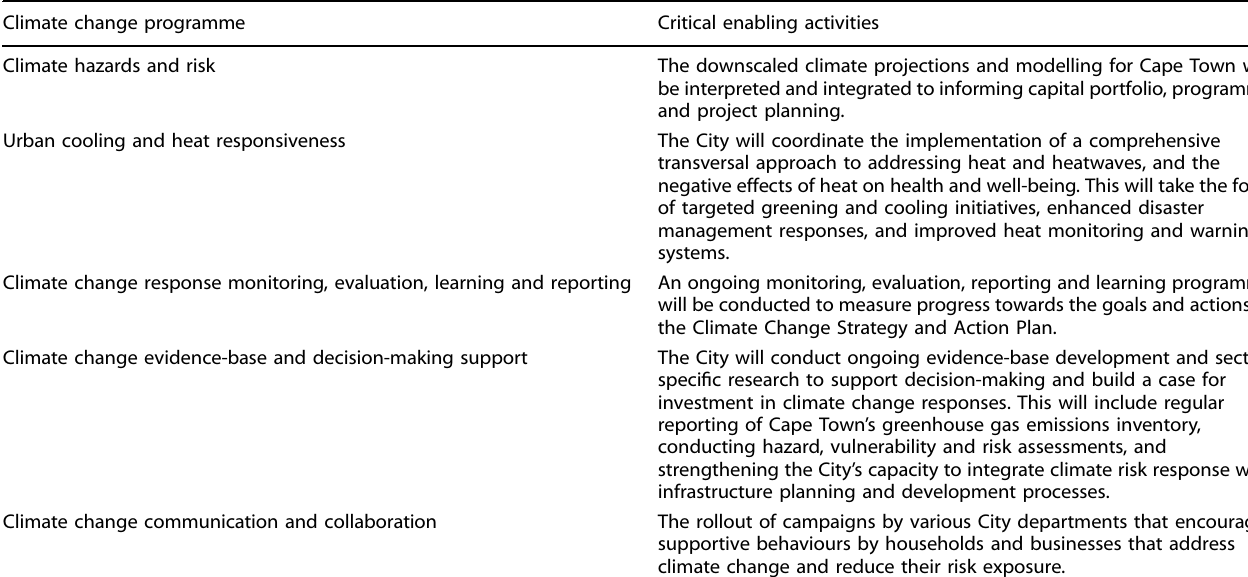
Fig. 1 The strategy of the City of Cape Town ’ s Integrated Development Plan 2022 – 2027 (adapted from 5 ). The fi gure shows the focus areas of the City of Cape Town over the next fi ve years. The City will focus on six priorities, the most important of which is economic growth to reduce poverty which is framed as ‘ inclusive economic growth ’ in text. The Climate Change Strategy is positioned within cross-cutting foundational principle of a ‘ Resilient City ’ in support of all six priorities. Table 1. Selected ‘ critical enabling activities ’ the City has committed to support the delivery of its IDP priorities and programmes development in the City of Cape Town ’ s Integrated Development Plan 2022 – 2027 5